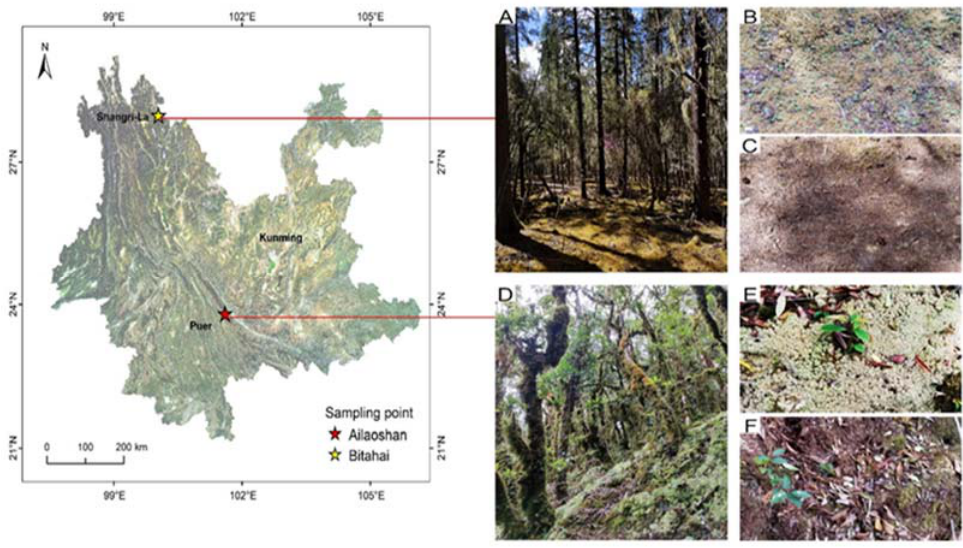
Figure 1. Schematic diagram of sampling sites and experimental treatments. Ailaoshan sampling site: Subtropical evergreen broad-leaved forest in Ailaoshan. Bitahai sampling site: Cold site: Subtropical evergreen broad ‐ leaved forest in Ailaoshan. Bitahai sampling site: Cold temperate coniferous forest in Bitahai. ( A ): Habitat at the experimental site in Ailaoshan, ( B ): No bryophyte removal in Ailaoshan, ( C ): Bryophyte removal in Ailaoshan, ( D ): Habitat at the experimental site in Bitahai, ( E ): No bryophyte removal in Bitahai, ( F ): bryohyte removal in Bitahai.